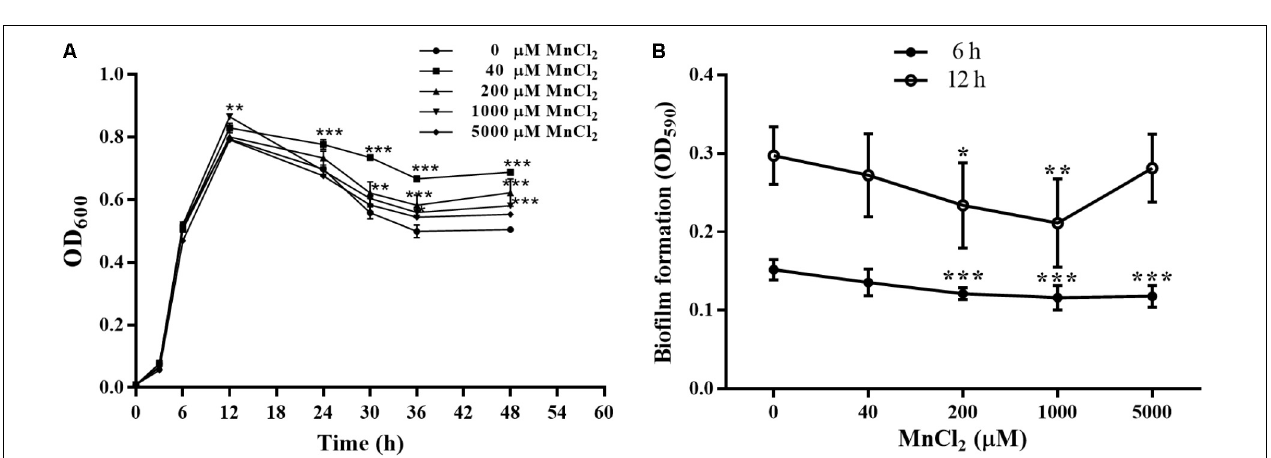
FIGURE 7 | Effect of exogenous Mn 2 + ion on the growth and biofilm formation by P. putida MnB1. (A) Microbial growth was detected by measuring the absorbance at 600 nm. P. putida MnB1 was incubated with 0, 40, 200, 1000, and 5000 µ M Mn 2 + , respectively. Biofilm formation by P. putida MnB1 was quantified by CV staining with absorbance at 590 nm. Cells were incubated with Mn 2 + (0, 40, 200, 1000, and 5000 µ M) for 6 and 12 h ( n = 6) (B) . Data were expressed as mean ± SEM. Significance, ∗ P < 0.05, ∗∗ P < 0.01, and ∗∗∗ P < 0.001 vs. control group (0 µ M MnCl 2 ).